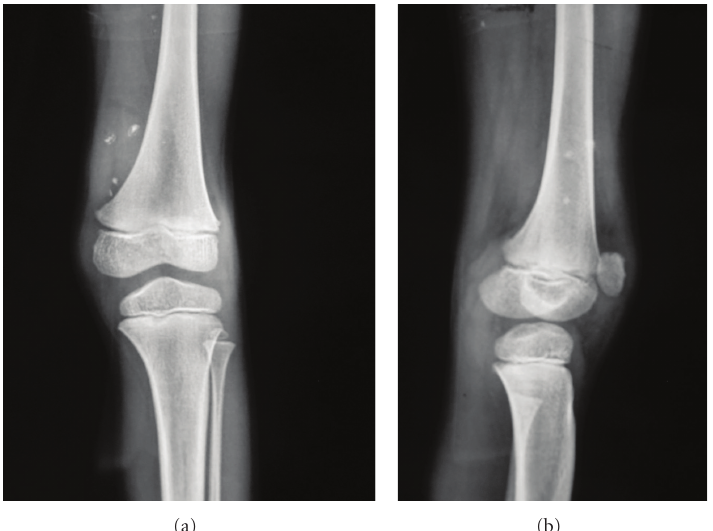
Figure 2: AP and lateral views of knee joint shows multiple phleboliths and minimal soft tissue swelling in suprapatellar region.